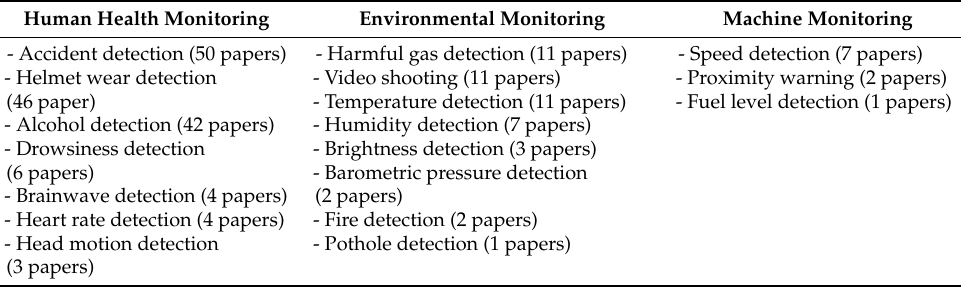
Table 4. Types of sensor depending on the purpose used in smart helmet studies.